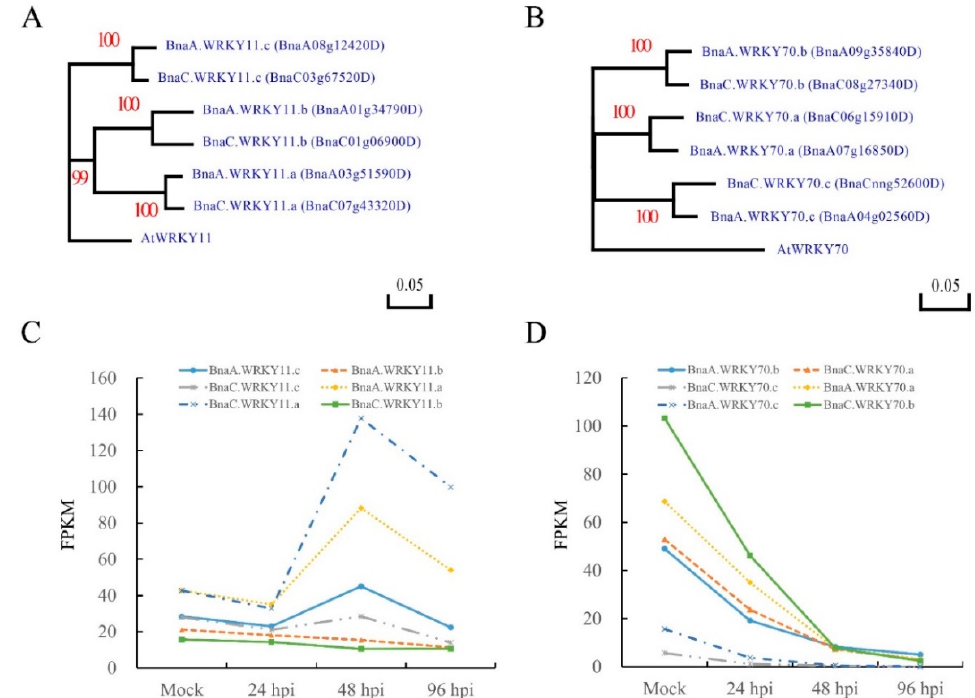
Figure 1. Phylogenetic tree of WRKY11 and WRKY70 and the expression level of BnWRKY11 and BnWRKY70 in response to S . sclerotiorum inoculation. ( A ) Phylogenetic tree of BnWRKY11 and the homologs from Arabidopsis ; ( B ) Phylogenetic tree of BnWRKY70 and the homologs from Arabidopsis ; ( C , D ) The expression level of BnWRKY11 and BnWRKY70 in response to S . sclerotiorum inoculation [51]. The tree was generated using the DNAMAN program by maximum likelihood (ML) methods. Bootstrap values are displayed with red numbers. hpi, hours post-inoculation.